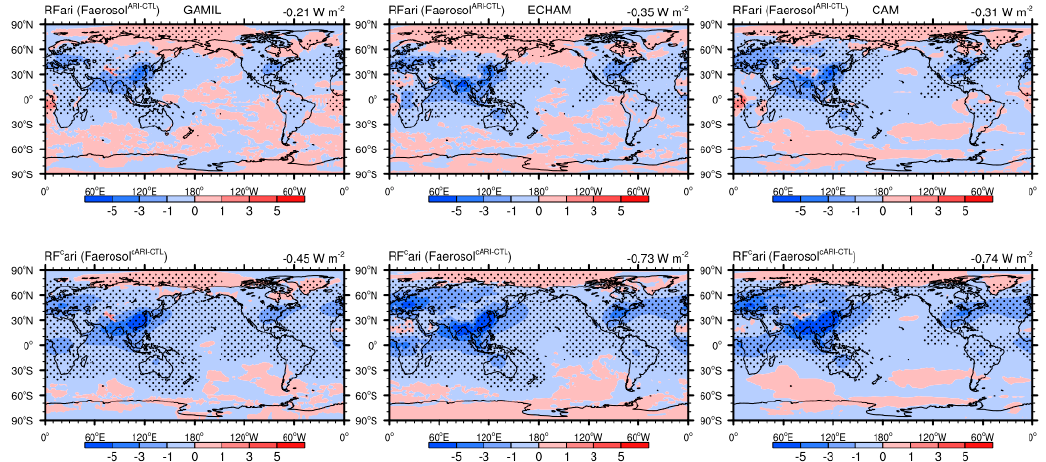
Figure 4. Anthropogenic aerosol all-sky (RFari = Faerosol ARI − CTL ) and clear-sky (RF c ari = Faerosol cARI − CTL ) instantaneous radiative forcing from the differences between the ARI and CTL experiments with the GAMIL (left), ECHAM (middle), and CAM (right) models. The number on the top right of the figure denotes the ensemble average of global annual mean values. Differences significant at the 10% level of the Student’s t -test are depicted by dots.